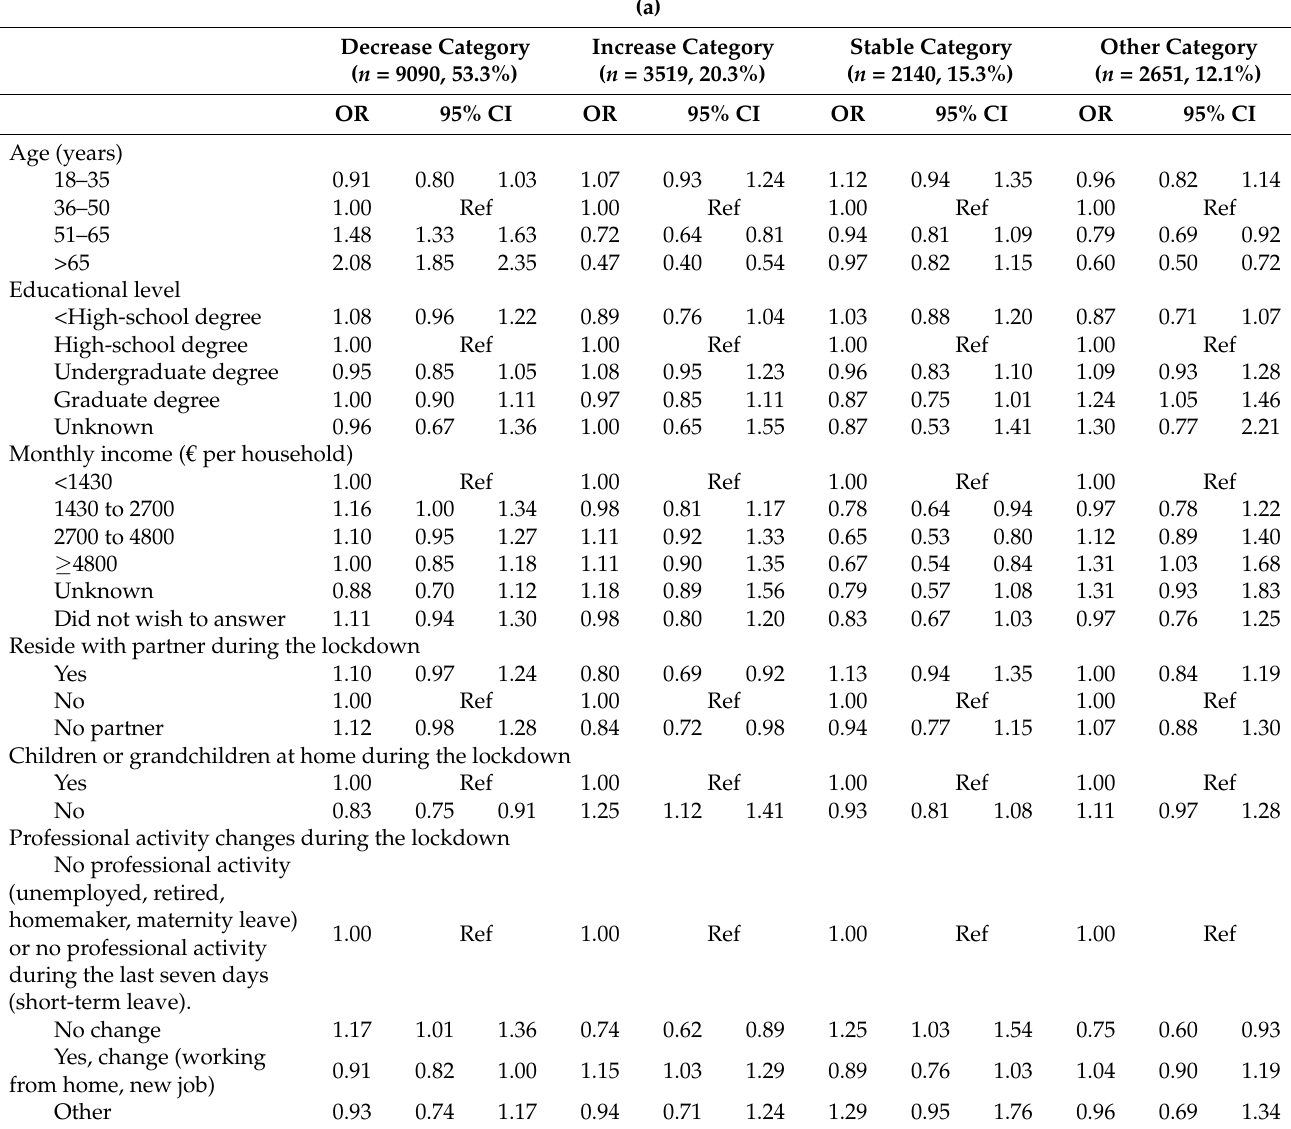
Table 3. a . Relationships between characteristics of women and categories of change in overall physical activity during the lockdown (T1 vs. T2). b . Relationships between characteristics of men and categories of change in overall physical activity during the lockdown (T1 vs. T2).